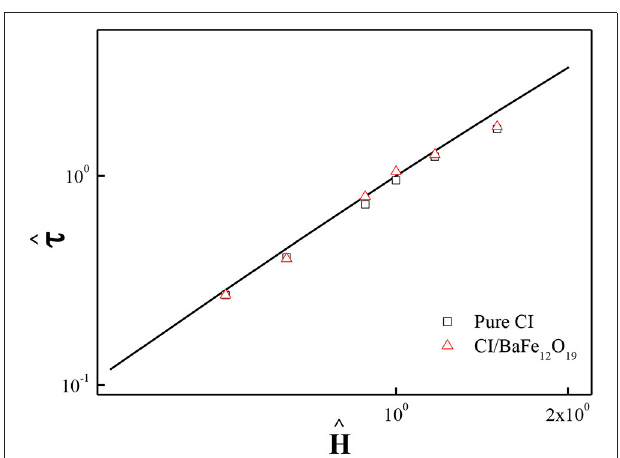
FIGURE 7 | Angular frequency sweep test for pure carbonyl iron (CI; closed symbol) and CI/BaFe 12 O 19 mixture–(open symbol) based MR fluids at constant strain